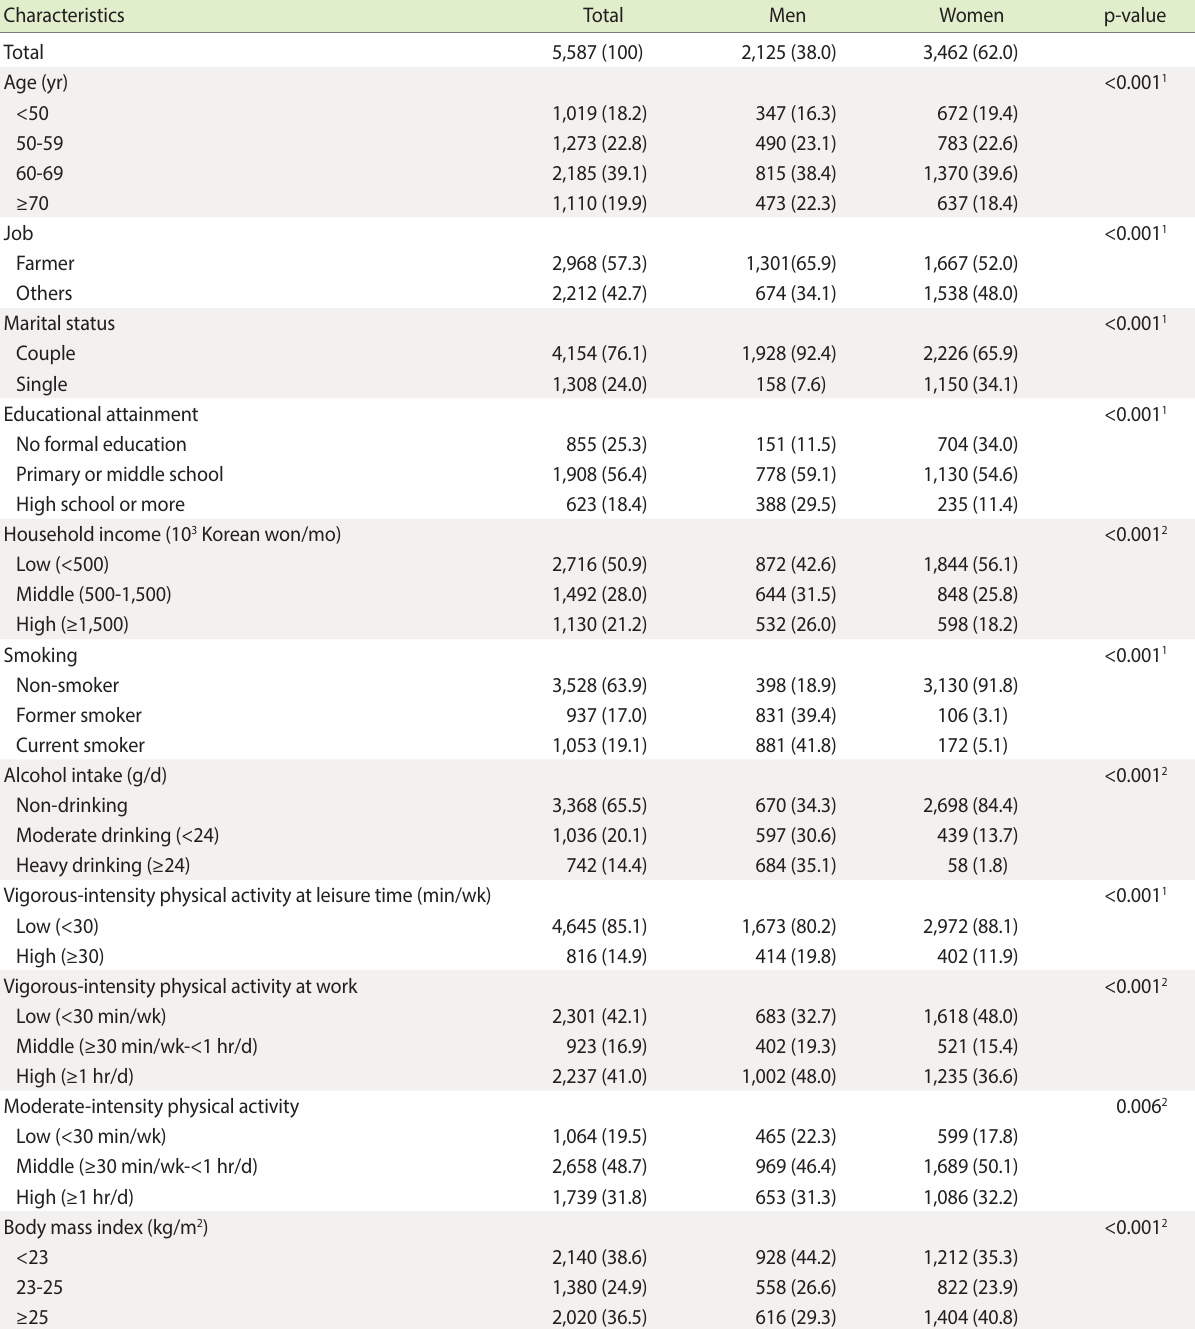
Table 1. General characteristics and physical activities of study subjects